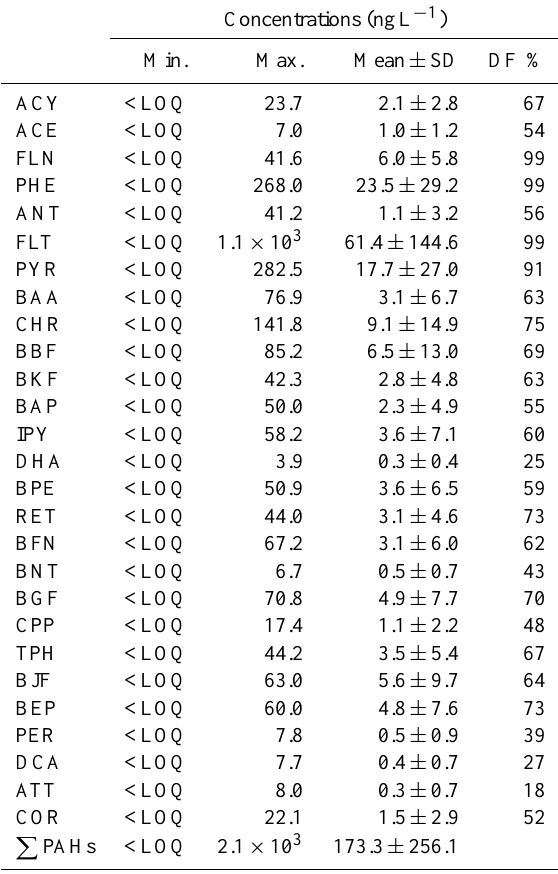
SD: standard deviation; <LOQ: below limit of quantification; P PAHs: the sum of the concentrations of 27 individual PAHs listed on the